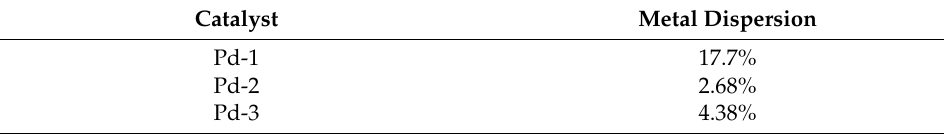
Table 3. Results of metal dispersion of catalysts Pd-1, Pd-2 and Pd-3. Table 3. results of metal dispersion of catalysts Pd-1, Pd-2 and Pd-3. Catalyst